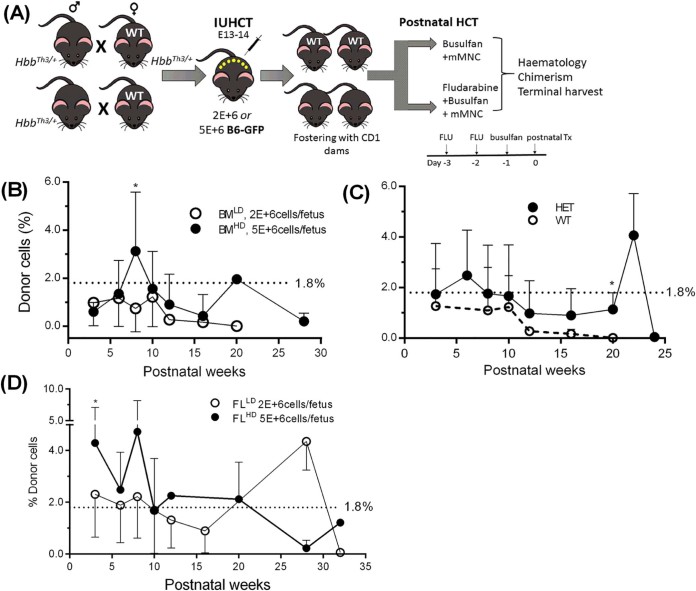
Murine adult BM and FL mononuclear cells transplanted into HbbTh3 murine fetuses. (A) BMLD (2E+6) or BMHD (5E+6) B6-GFP donor cells were administered to E13–E14 pups (HbbTh3/+ males × HbbTh3/+ or B6 females). (B) This produced overall chimerism of 0.6 ± 0.5% vs. 1.3 ± 0.9%, respectively (p = 0.06), significant at 8 weeks (0.7 ± 0.9% vs. 3.1 ± 2.5%, p = 0.001). (C) HET mice had higher chimerism compared with WT after BMLD treatment (1.6 ± 0.4% vs. 0.7 ± 0.2, p = 0.05) and maintained low chimerism of 0.9–4.1% until 24 weeks, whereas WT chimerism (0.2–1.7%) was lost by 20 weeks. (D) FLLD demonstrated 0.9–4.4% chimerism until 32 weeks; FLHD showed 0.2–4.7% chimerism (>1% at 32 weeks). Mean chimerism was similar between the groups (2.4 ± 1.5% FLHD vs. 1.8 ± 1.2% FLLD, p = 0.45). There were no surviving HET FL-IUHCT pups. *p < 0.05.